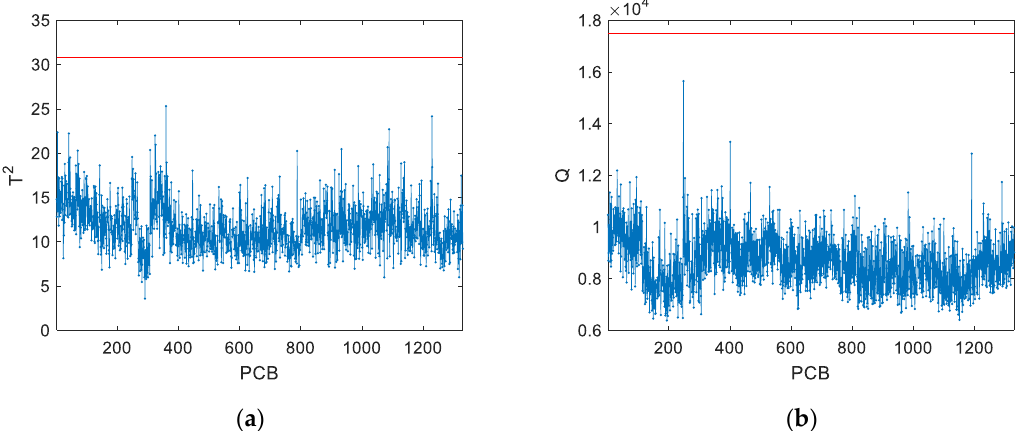
Figure 18. Control charts for the PCBs in CS3: ( a ) T 2 -statisctic; ( b ) Q -statistic.